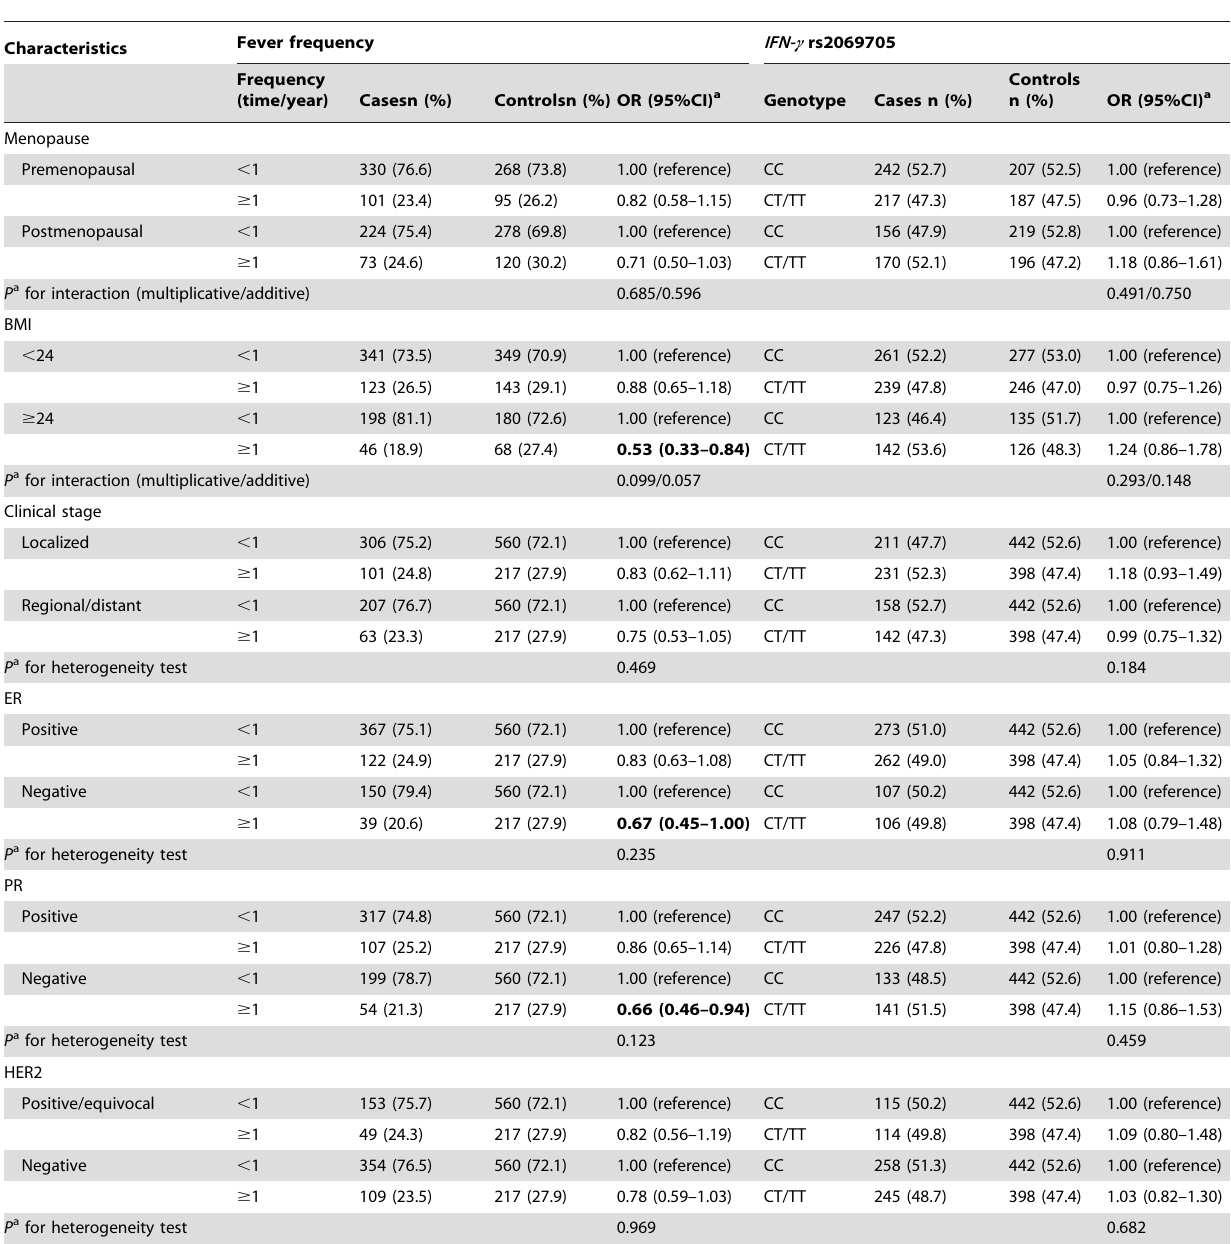
Table 3. Multivariate odds ratio of breast cancer associated with previous fever frequency stratified by clinicopathological